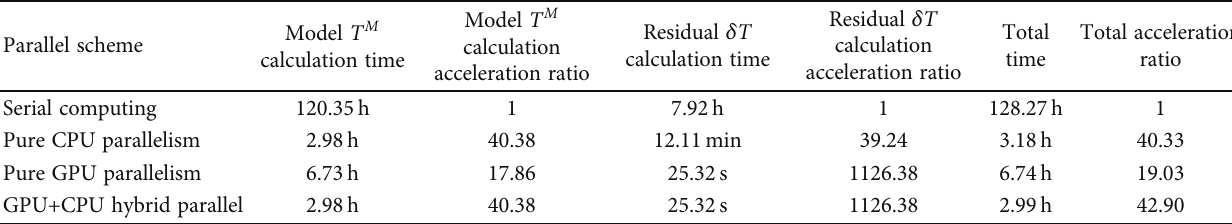
Table 9: Time consumption of the di ff erent parallel